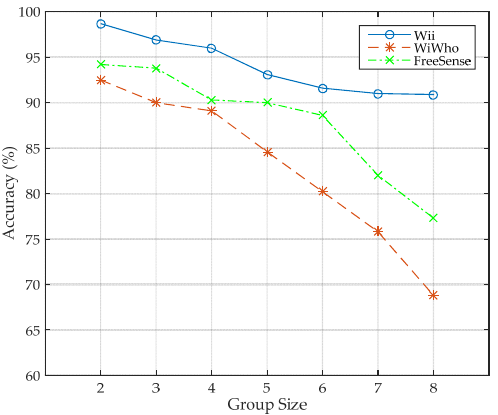
Figure 12. Performance with different group sizes.